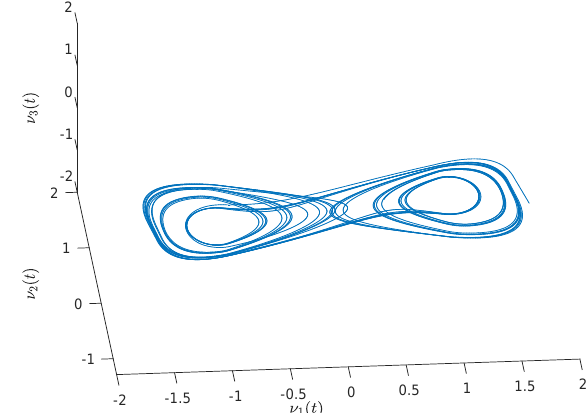
Figure 3. Phase diagram of system